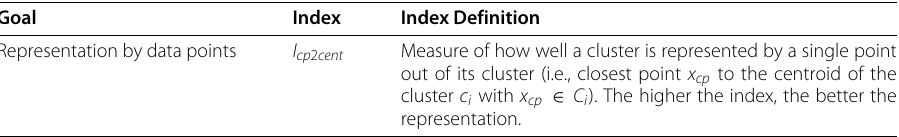
Table 3 New index for good representation of data points